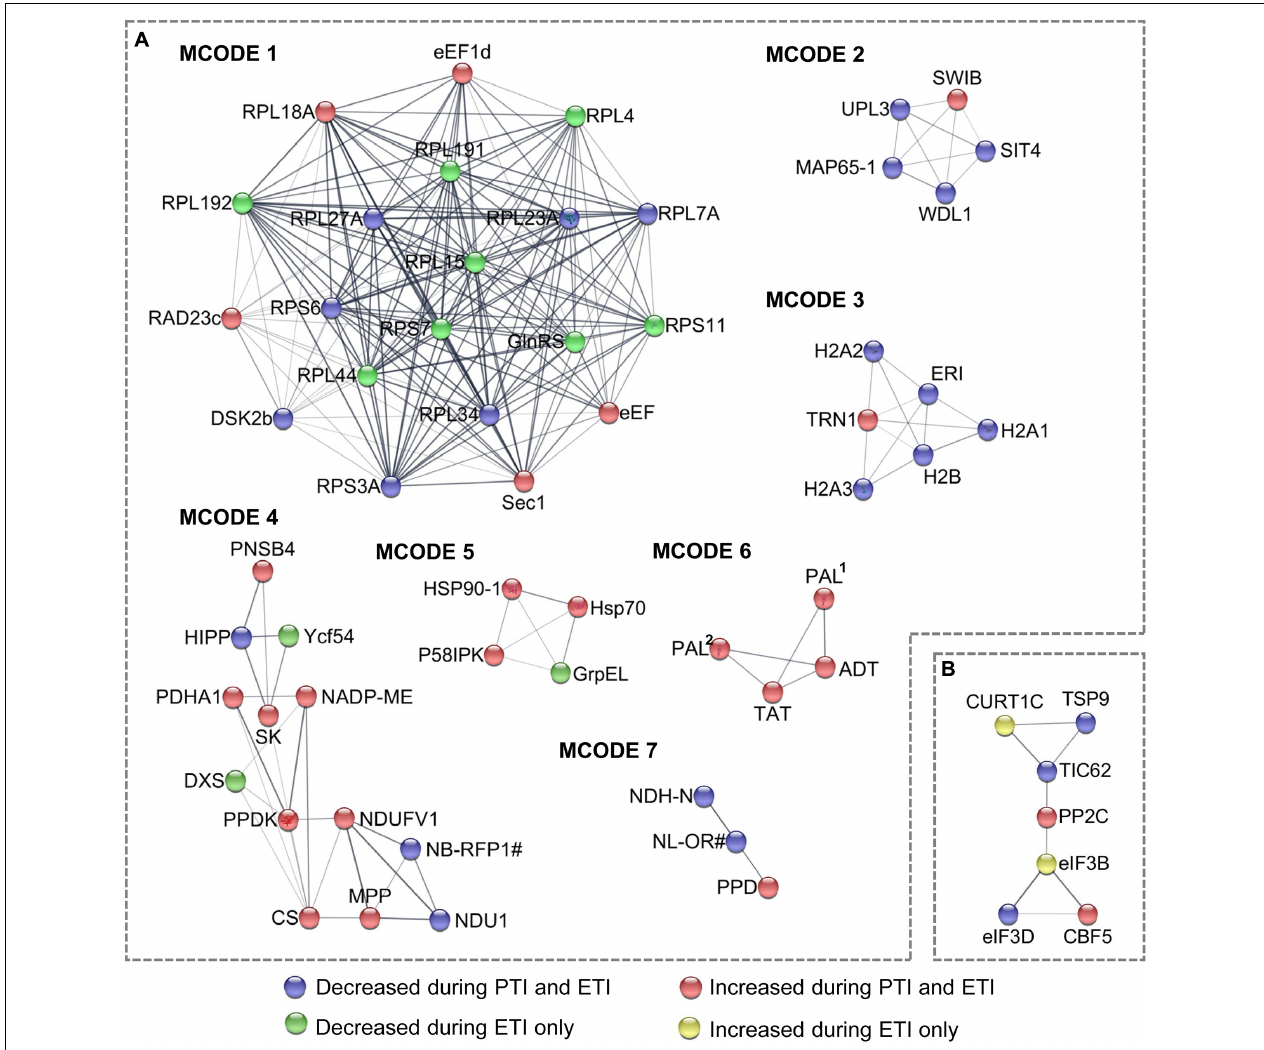
FIGURE 3 | Subnet module analysis of the protein-protein interaction (PPI) network. (A) DR proteins; and (B) DR phosphoproteins. Different colors of the nodes correspond to the Clusters in Figure 1C , which represent different change patterns of the DR proteins and phosphoproteins, as shown at the bottom of the figure. refer to Supplementary Tables 2, 3 for